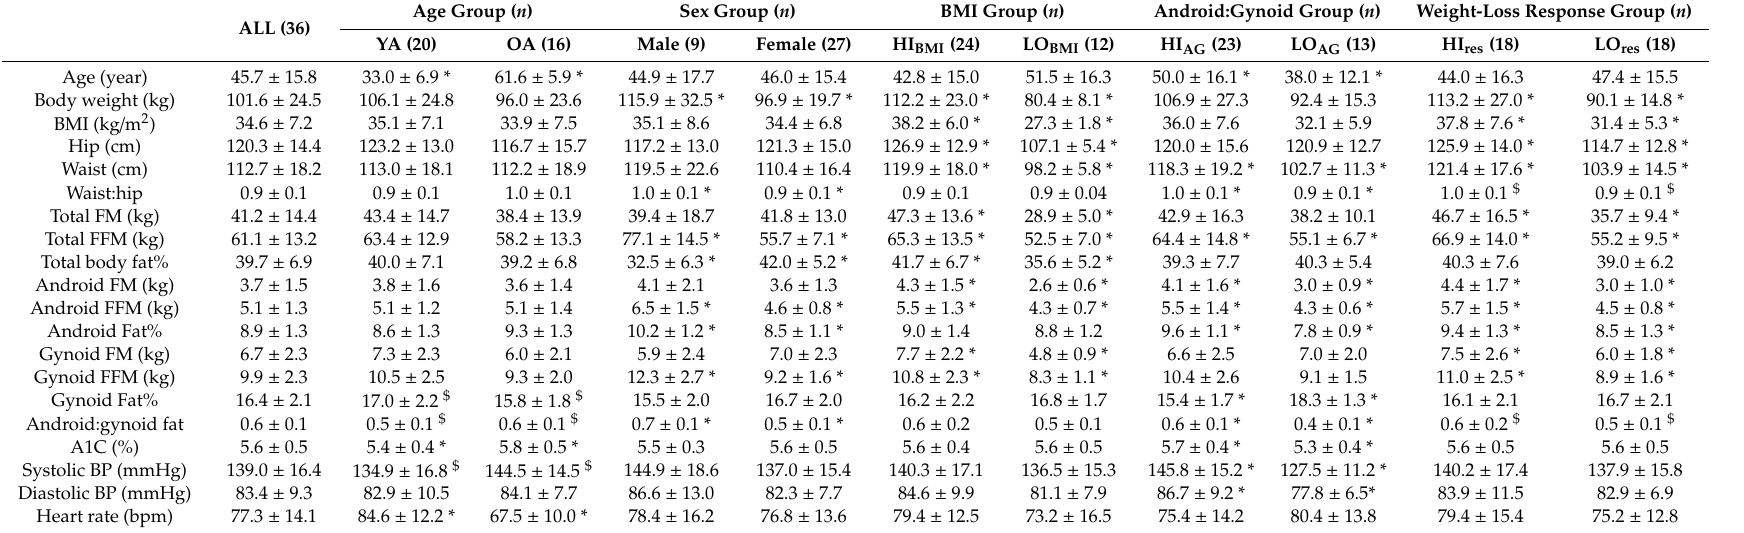
Table 2. Baseline characteristics of study participants including di ff erential features between